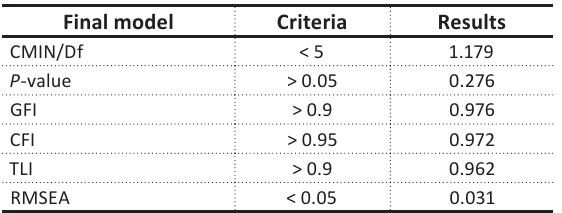
Table 3. Goodness of fit index for the model